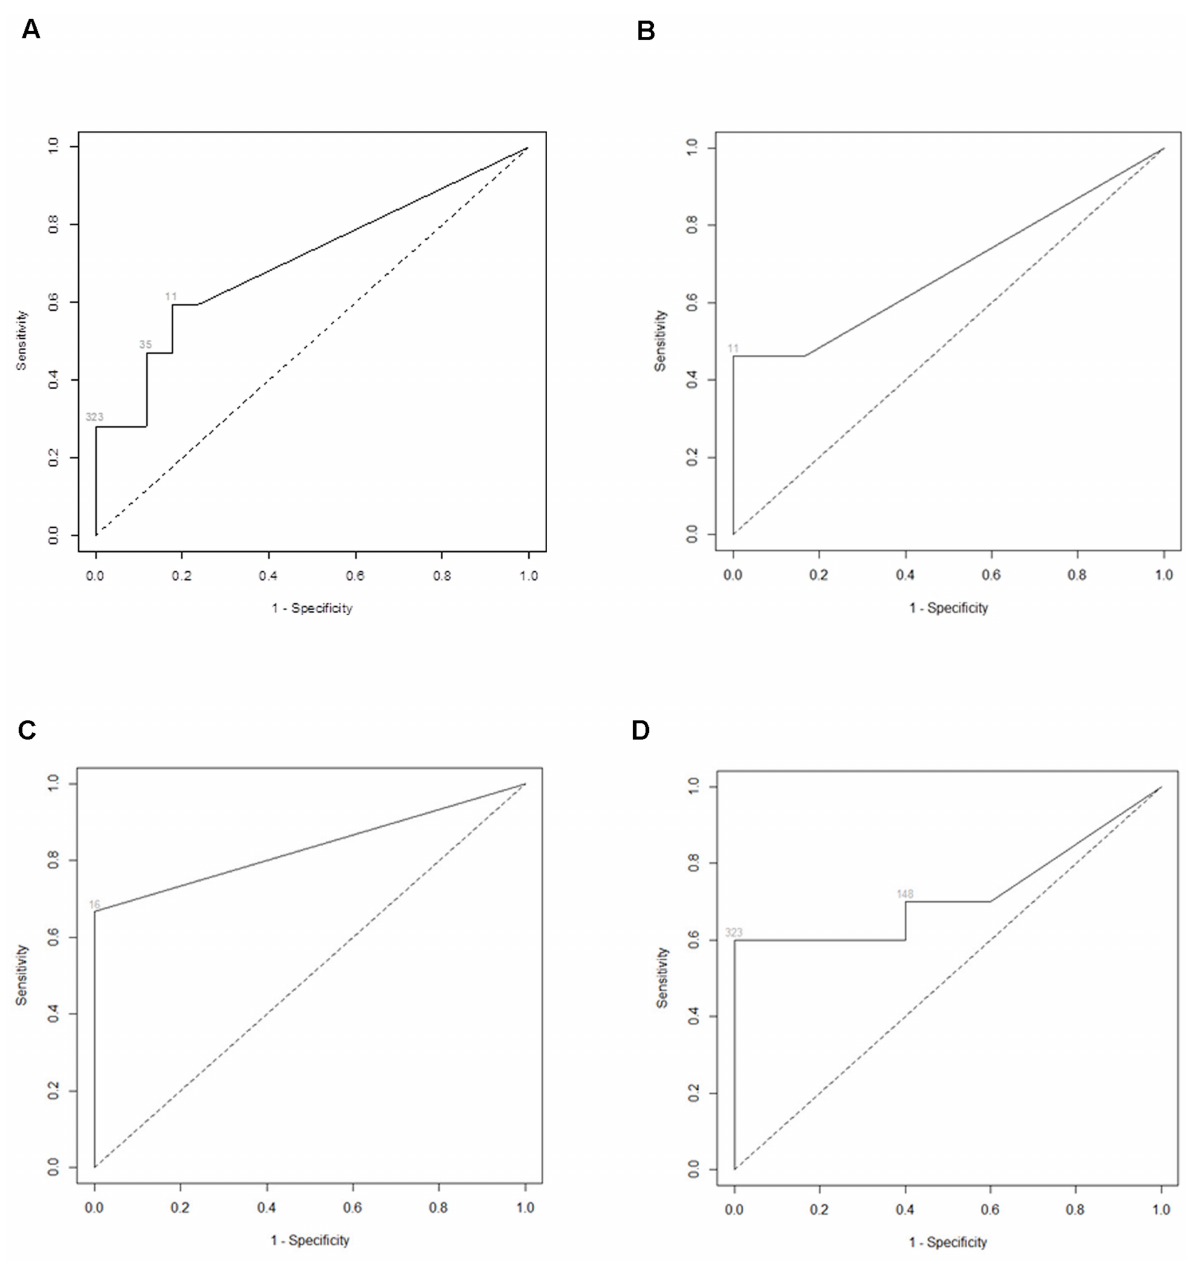
Figure 4. Receiver operating characteristic (ROC) curves for homotypic neutralizing antibody titers (NTs) against reference strains. Curves discriminate between dengue virus (DENV) PCR positive and negative subjects for: (a) all serotypes combined; (b) DENV-1; (c) DENV-4; (d) DENV-2.